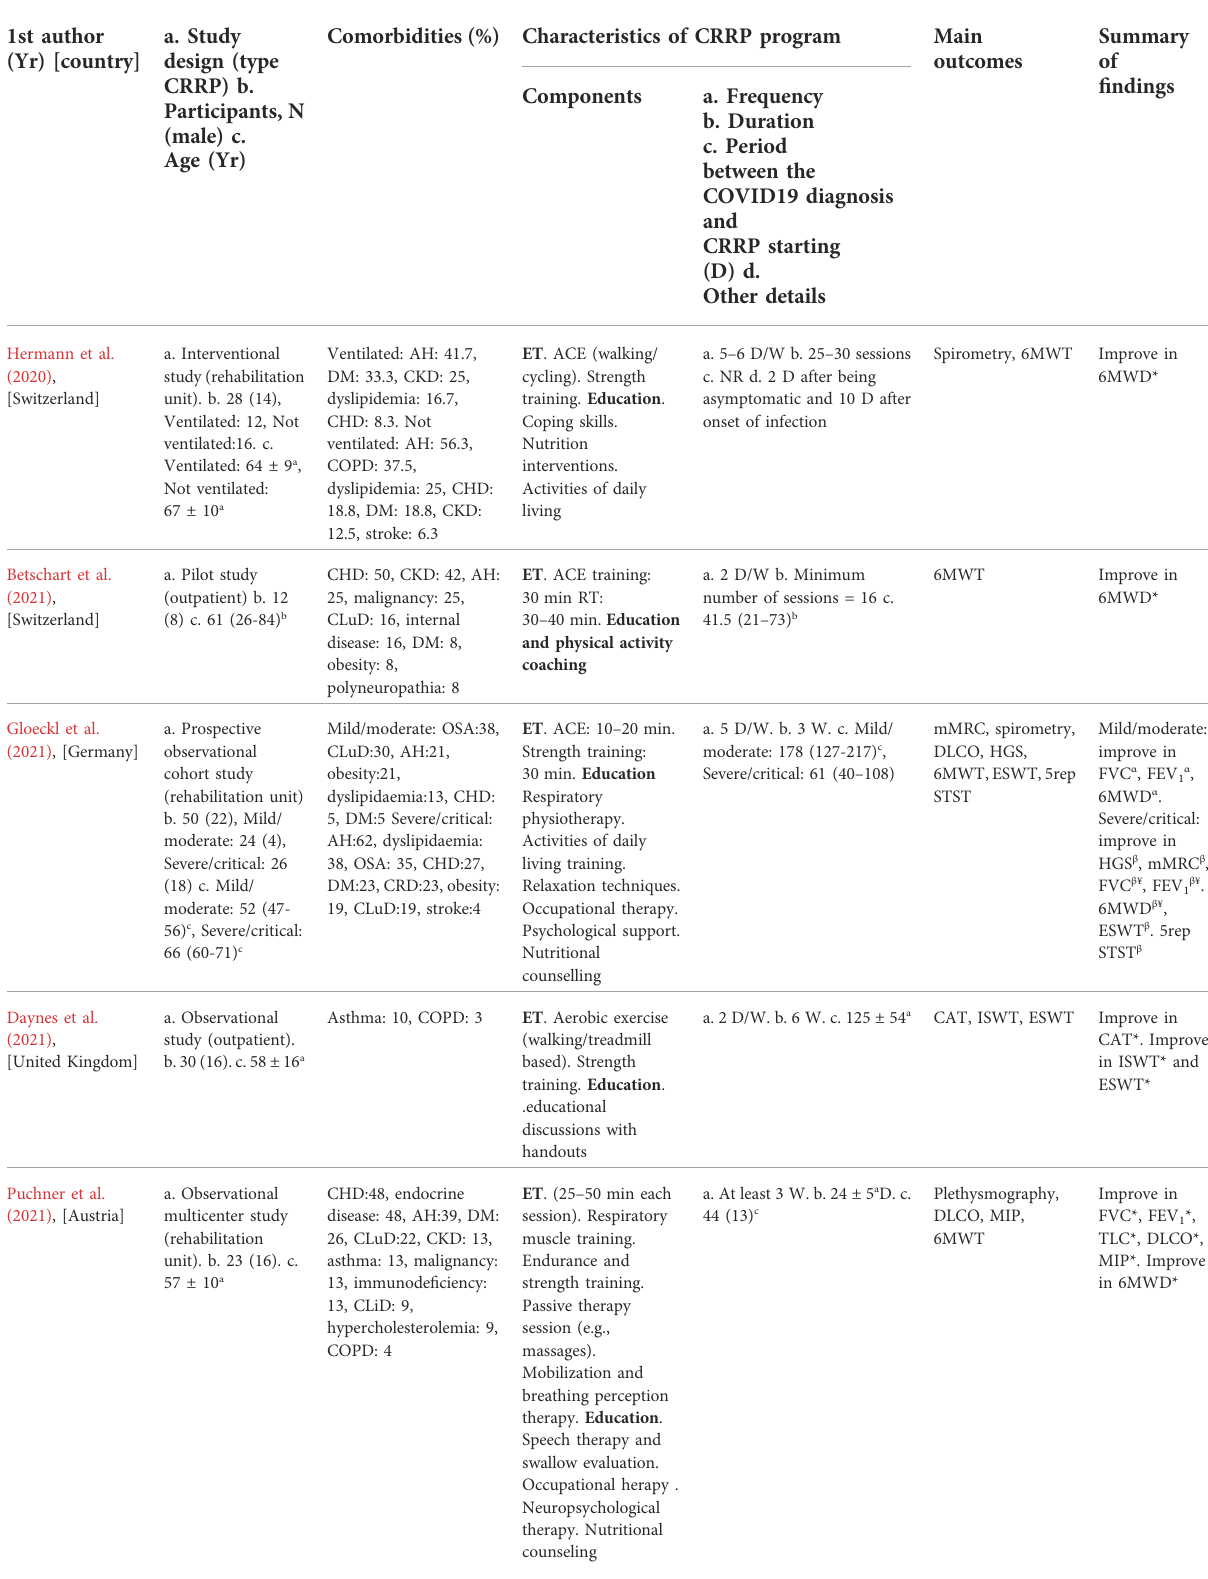
TABLE 4 Methodology and main outcomes of some studies including a single group of COVID19 patients, and aiming at evaluating the impacts of CRRP on COVID19 patients. 1st author a. Study (Yr) [country] design